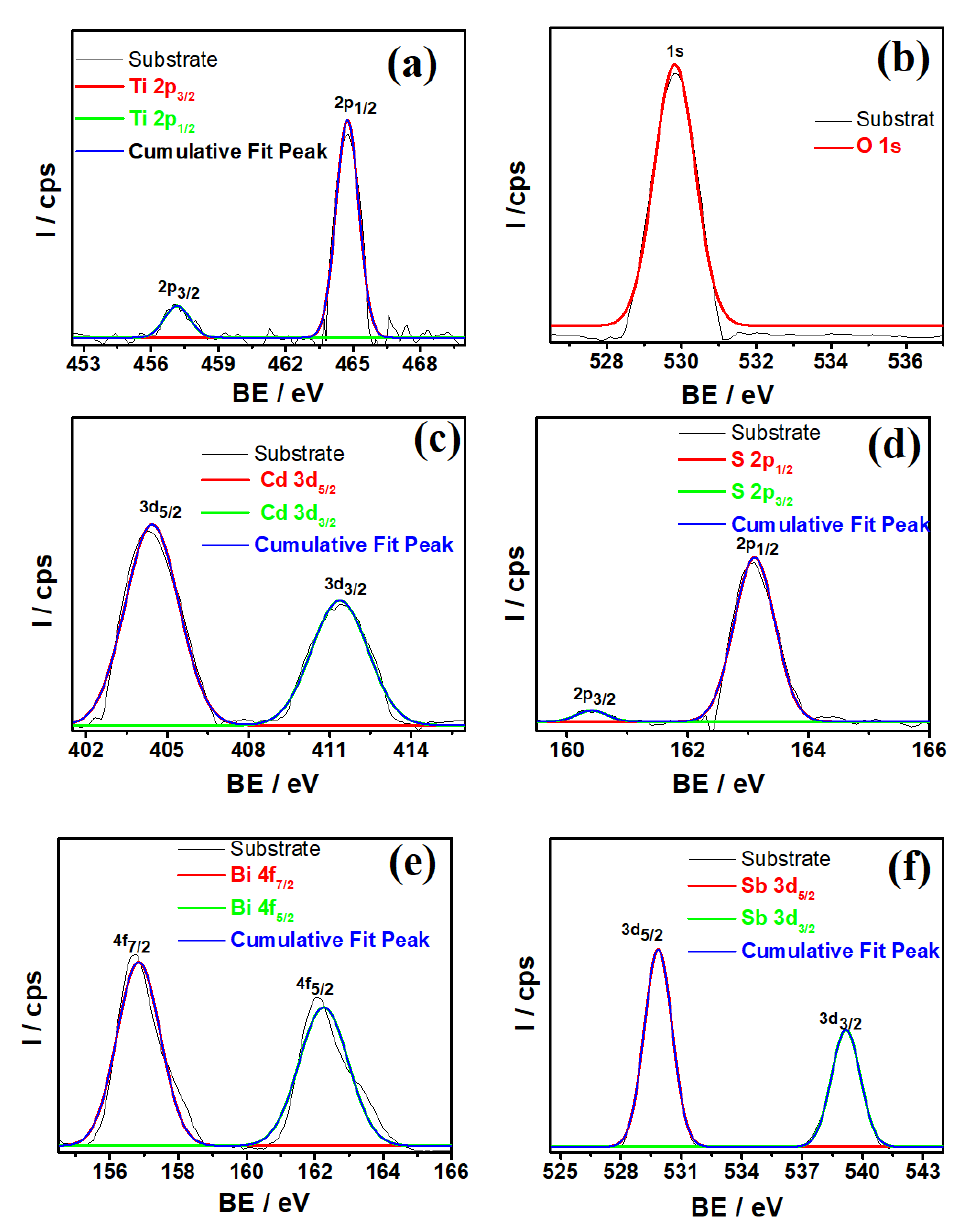
Figure 3. XPS spectra of ( a ) Ti 2p, ( b ) O 1s, ( c ) Cd 3d, ( d ) S 2p, ( e ) Bi 4f, and ( f ) Sb 3d.